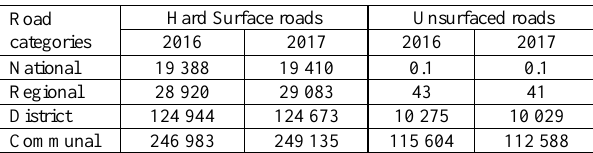
Table 1. Polish road infrastructure between 2016–2017